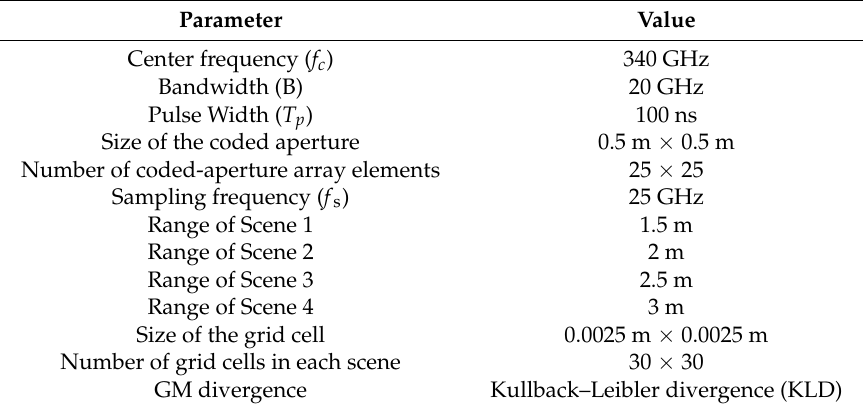
Table 2. Primary parameters used in the